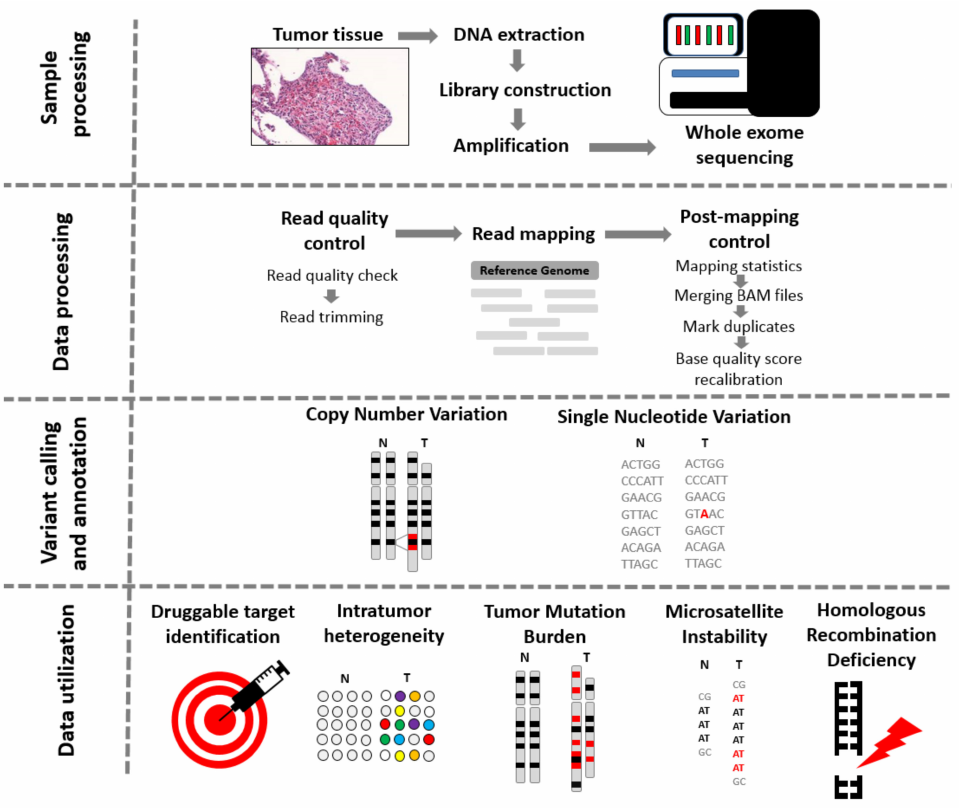
Figure 1. From tissue to data—steps of whole exome sequencing. Tissue preprocessing starts with the identification of tumor regions by an experienced pathologist, followed by DNA extraction, library construction, and amplification. Data procession commences with the quality check of